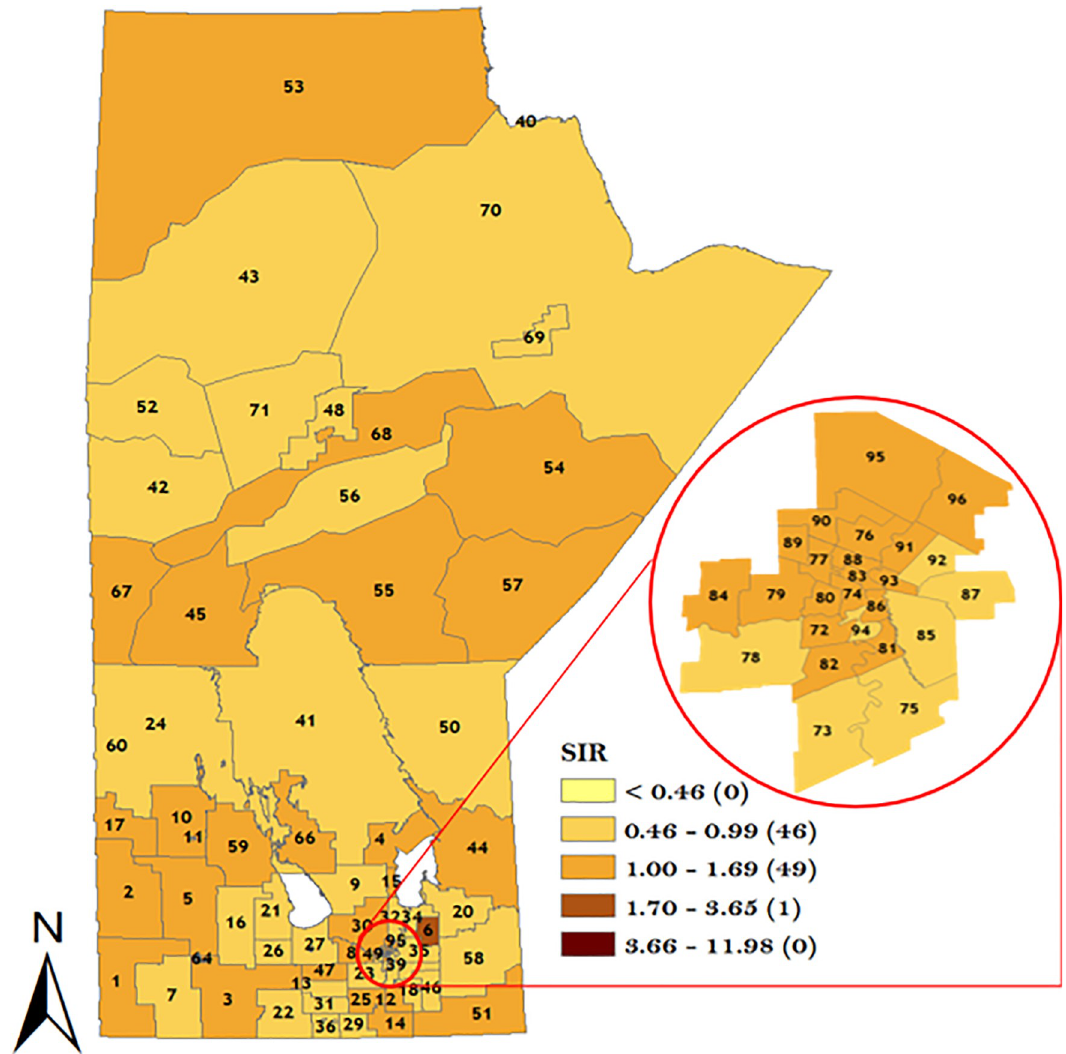
Fig 8. Map of standardized IRR of overall GC in Manitoba women using spatial Poisson regression model. Numbers in the map are the district labels from 1 to 96. Number of districts in each risk category is shown in parenthesis in the